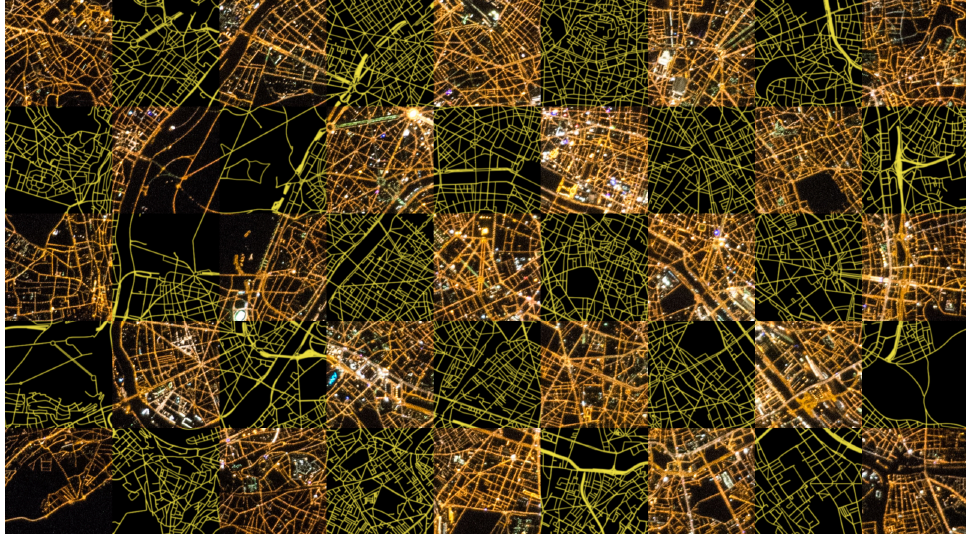
Figure 4. Subset of georeferenced NTL image of Paris overlaid onto the reference NTL